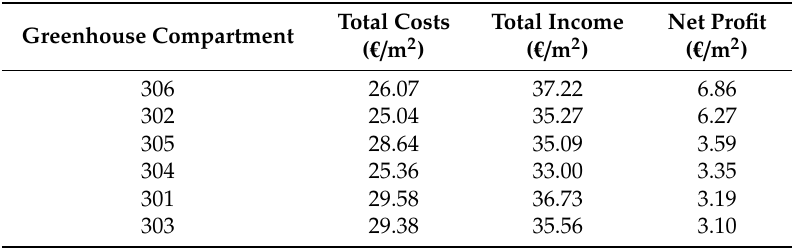
Table 3. Total costs, total income, and net profit ( € / m 2 ) for di ff erent teams and greenhouse